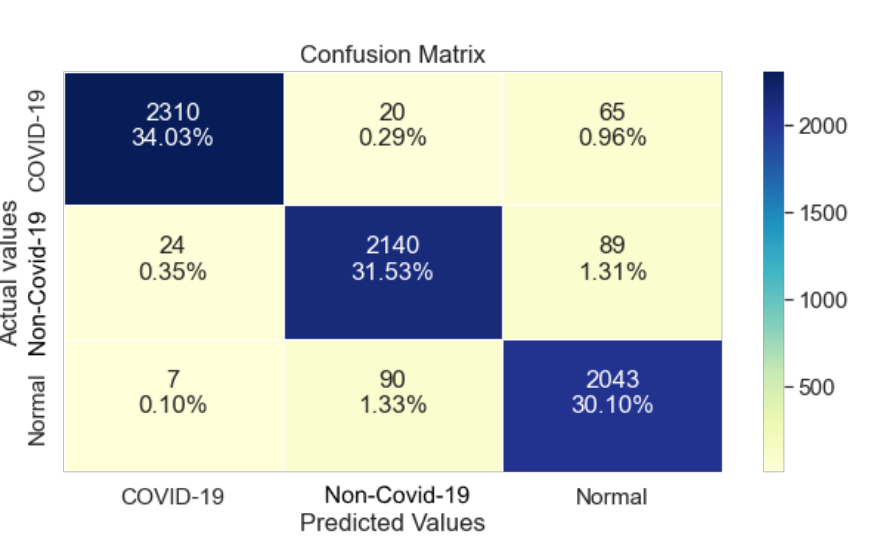
Figure 4. ResNet101 Confusion Matrix.